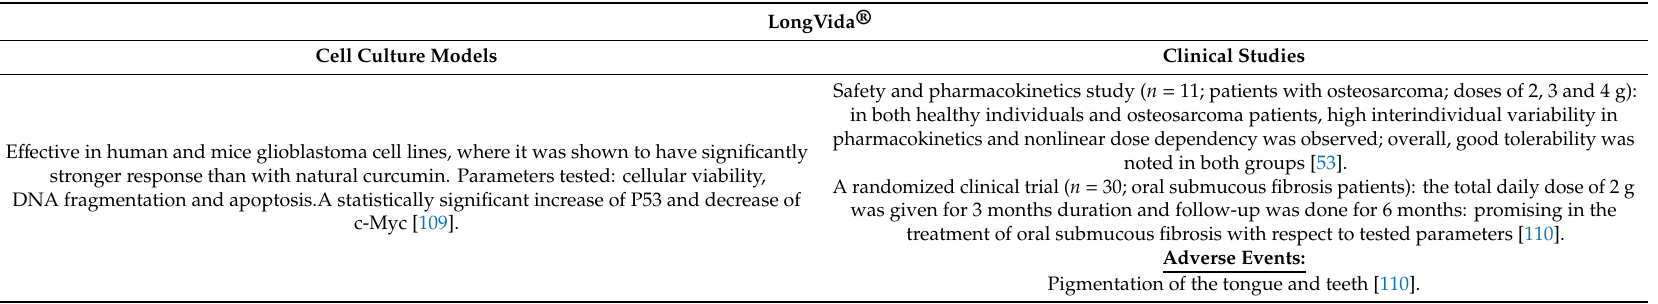
Table 5. E ff ects of LongVida ® obtained in vitro, in vivo and in clinical